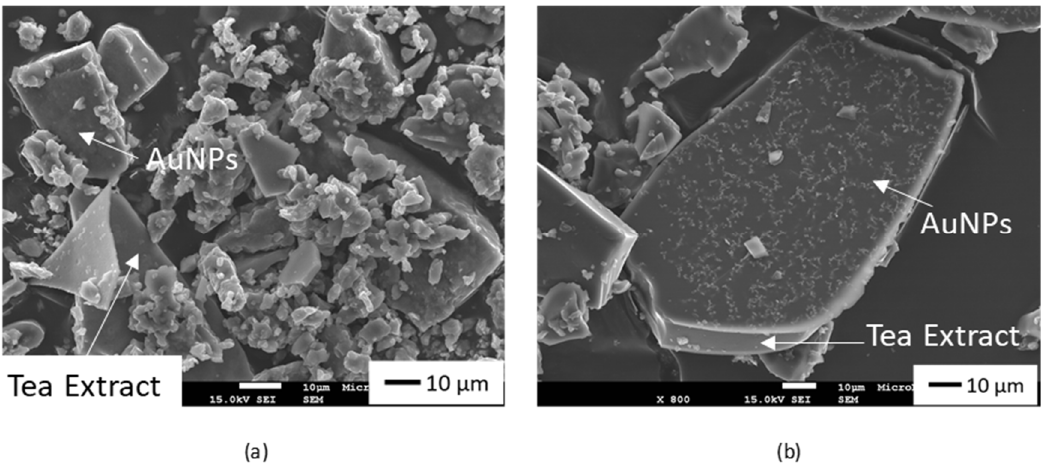
Figure 4. Scanning electron microscopy (SEM) images of ( a ) AuNPs 1% tea and ( b ) AuNPs 10% tea.